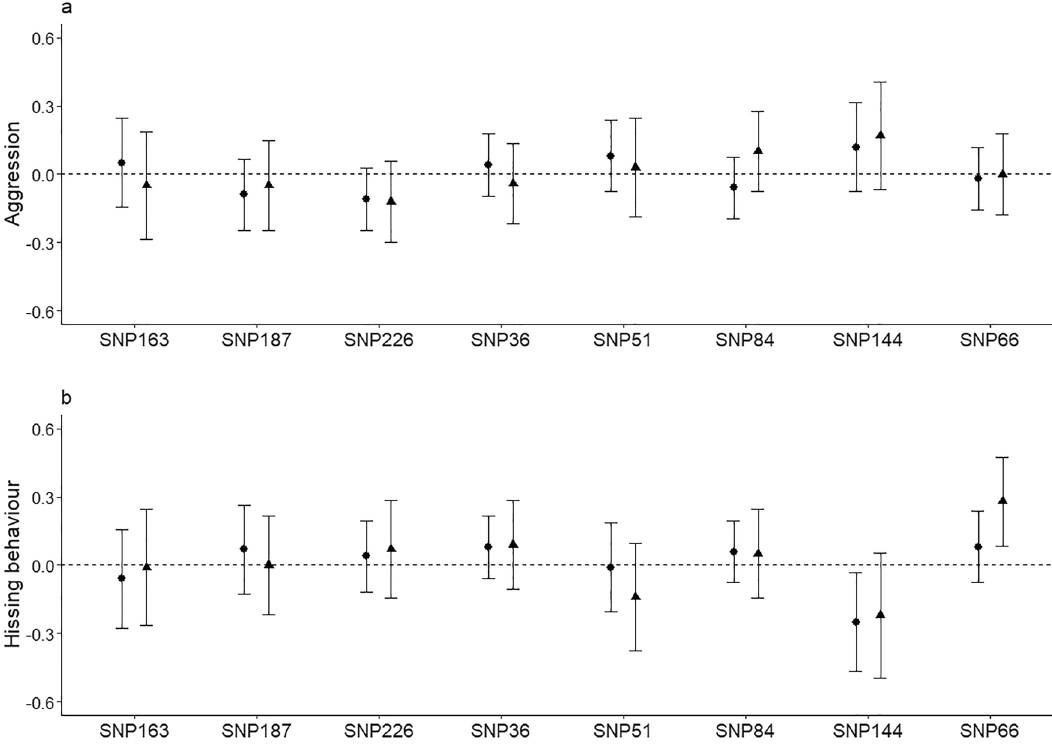
Figure 1. Effect size with 95% confidence intervals (CIs) of SERT SNPs for female-female aggression ( a ) and hissing behaviour ( b ) from the additive effect (circles) and the overdominant effect (triangles) models. For the additive model, positive effects indicate the average increase, and negative effects the average decrease in aggression/hissing behaviour with successive replacement of alleles. For the overdominant model, positive effects indicate the average increase, and negative effects the average decrease in aggression/hissing behaviour from homozygous individuals to heterozygous individuals. Effects are significant (with P < 0.05, but P.adjust > 0.05) when CIs do not overlap with zero (dotted lines).